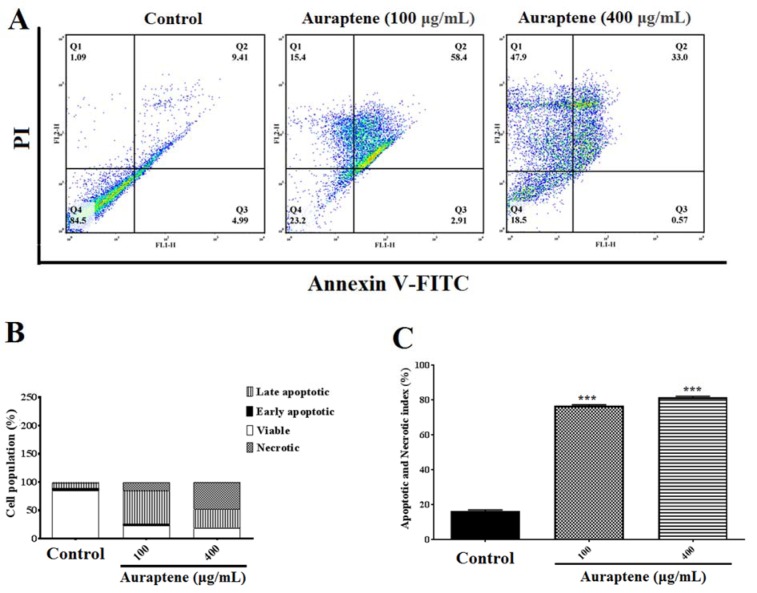
(A) The measurement of apoptotic and necrotic cells was performed by the annexin V-FITC/PI double-staining assay 48 hours after treatment by auraptene (100 and 400 μg/mL). Auraptene induced apoptosis concentration-dependently manner 24 hours after treatment compared to the control group. FL2-H and FL1-H are PI and annexin V-FITC, respectively. The annexin V-FITC conjugated protein was bound to the phosphatidyl serine-expressing cell surface, which is an early apoptosis marker. The cells were stained with PI, a non-penetrating color to the DNA, indicating necrotic cells. The cells stained with PI and annexin V-FITC represent the endpoints of apoptosis and the initial phase of necrosis. The percentages of viable, early/late apoptotic, and necrotic cells in the treated samples compared to the control group, 48 hours after treatment by auraptene (Q1: annexin V−/PI +, necrotic cells; Q2: annexin V+ /PI +, late apoptotic cells; Q3: annexin V+ /PI −, early apoptotic cells; Q4: viable cells). Tests were repeated in triplicate. (B) and (C) show the percentage of apoptosis process in each phase and the apoptotic and necrotic index in the treated samples as compared with the control group, 48 hours after treatment, respectively. Each column represents the mean±standard error in the samples. *** P<0.001 as compared with the control group (n=5)